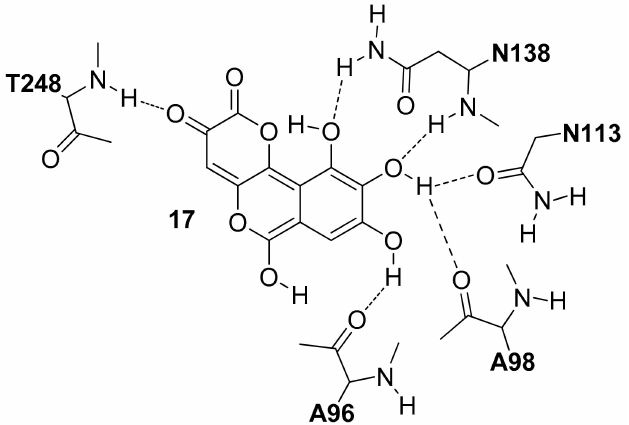
Figure 8. Schematic 2D representation of the 17 – h LDH5 H-bond